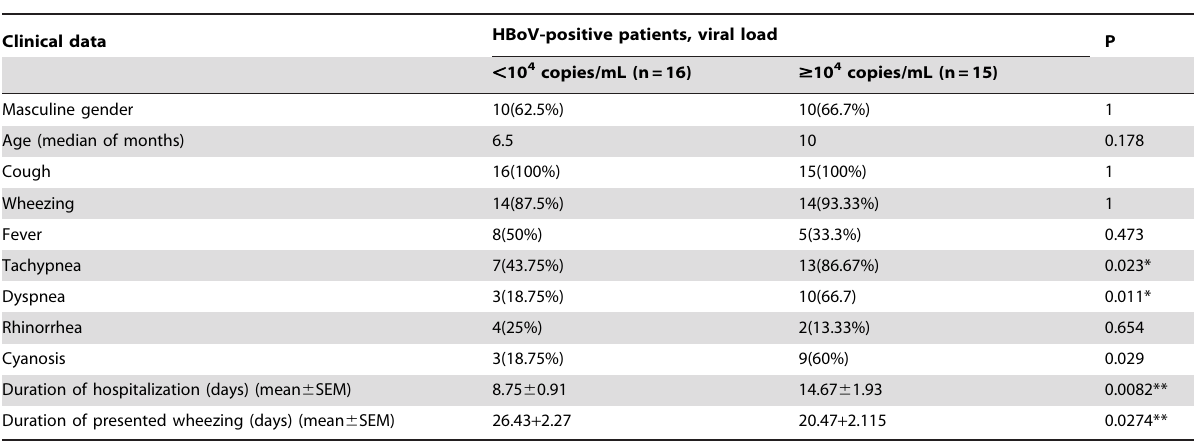
Table 5. Clinical data of patients with different HBoV viral load.